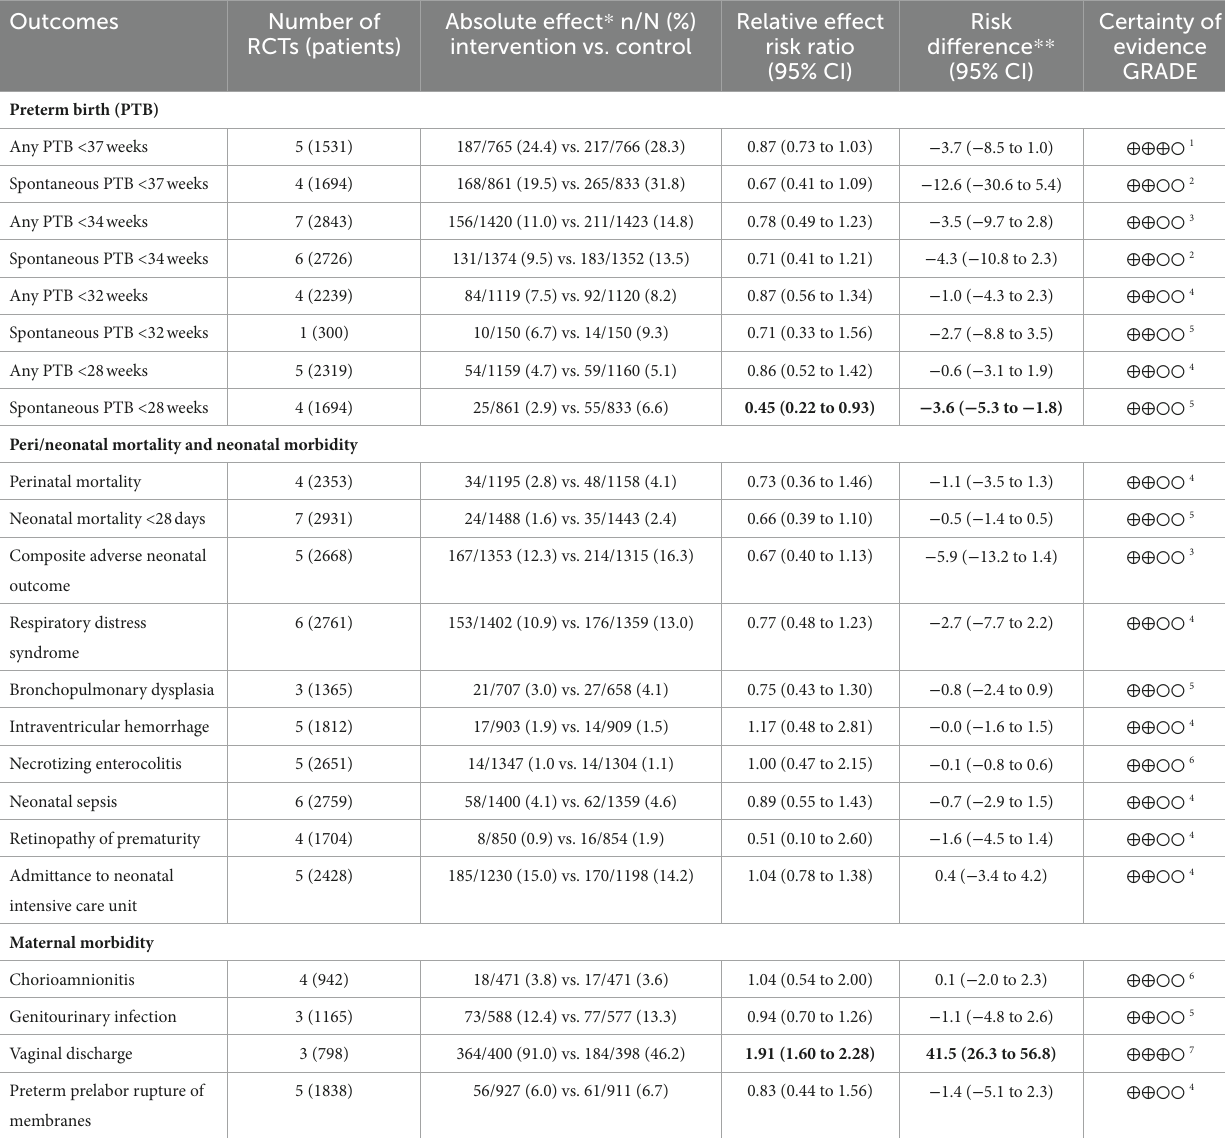
TABLE 4 Summary of findings for main outcomes (based on trials with low risk of bias): Pessary vs. no pessary in women with a singleton pregnancy and short cervical